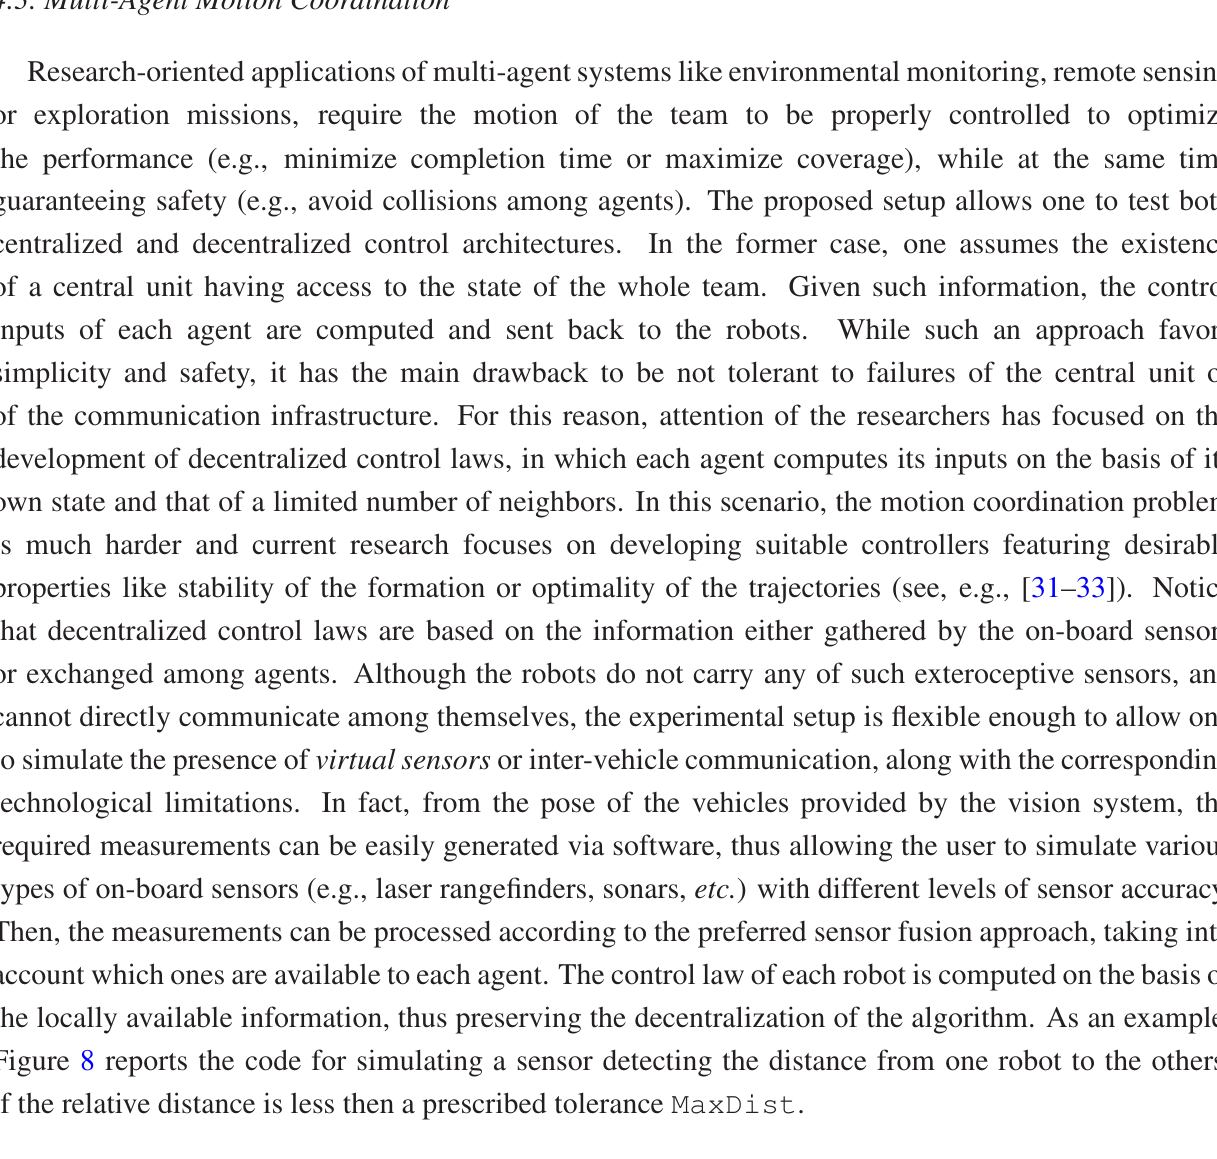
Figure 8. Example of function for distance